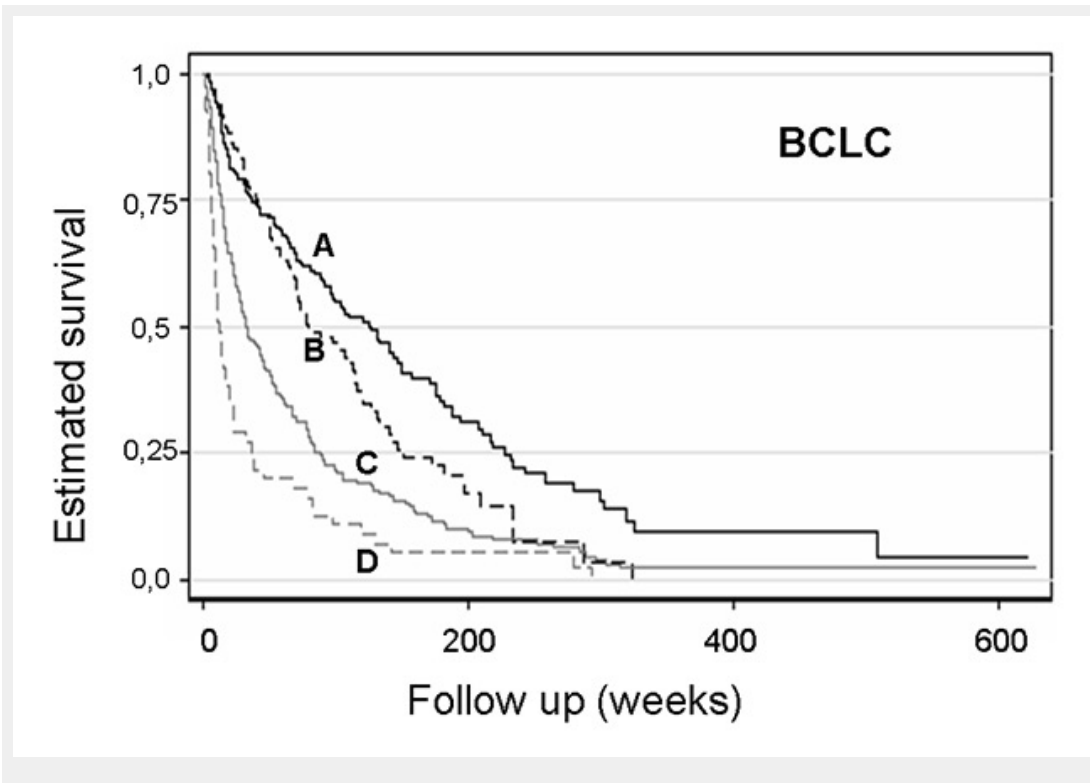
Figure 3 Kaplan-Meier curve for survival by BCLC score in patients with hepatocellular cancer (n = 6, 160, 94, 169 and 5 for BCLC 0, A, B, C and D, respectively; p <0.001 for B vs A, C vs B and D. C). BCLC = Barcelona clinic liver cancer